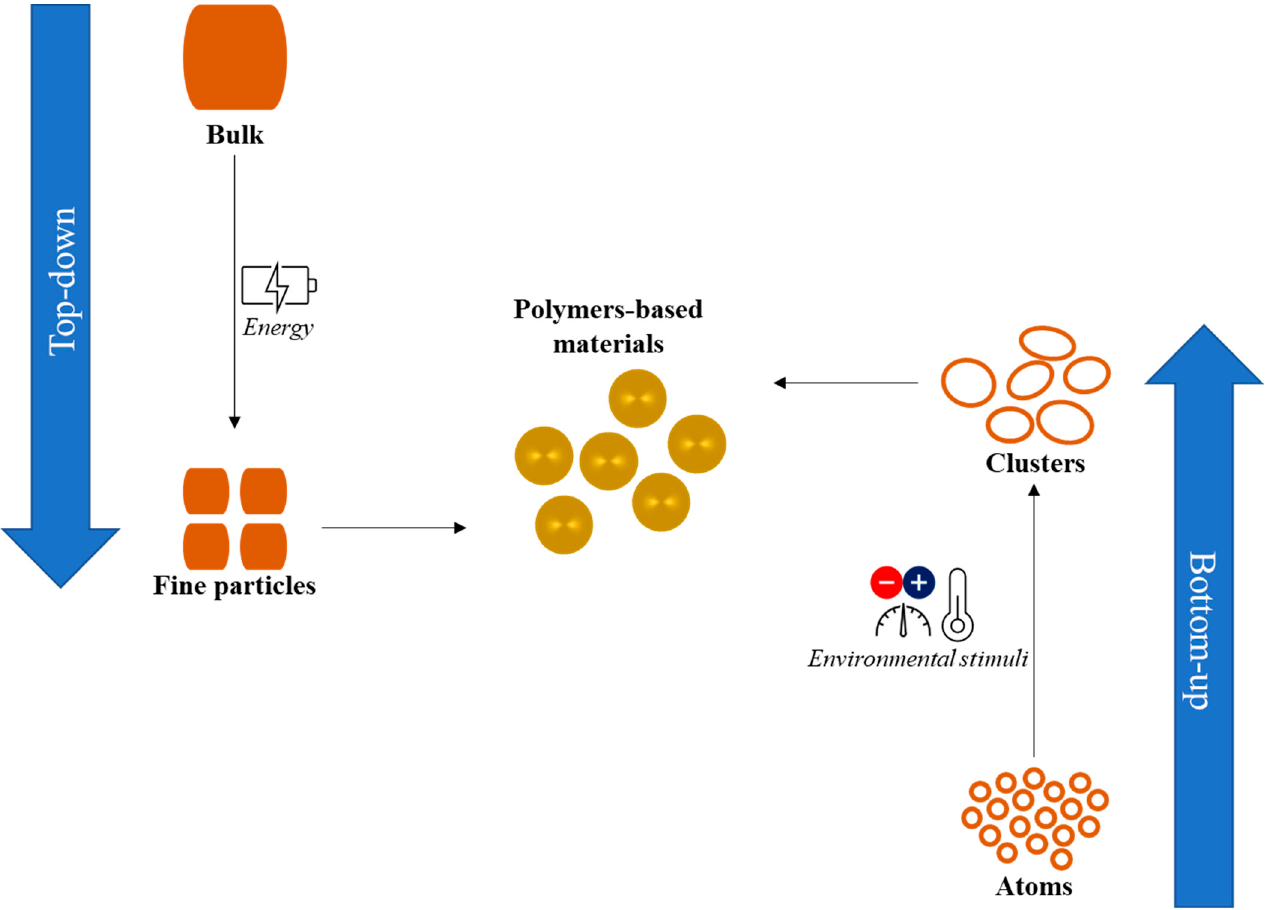
Figure 1. Schematization of top ‐ down and bottom ‐ up synthesis of polymer ‐ based particles.